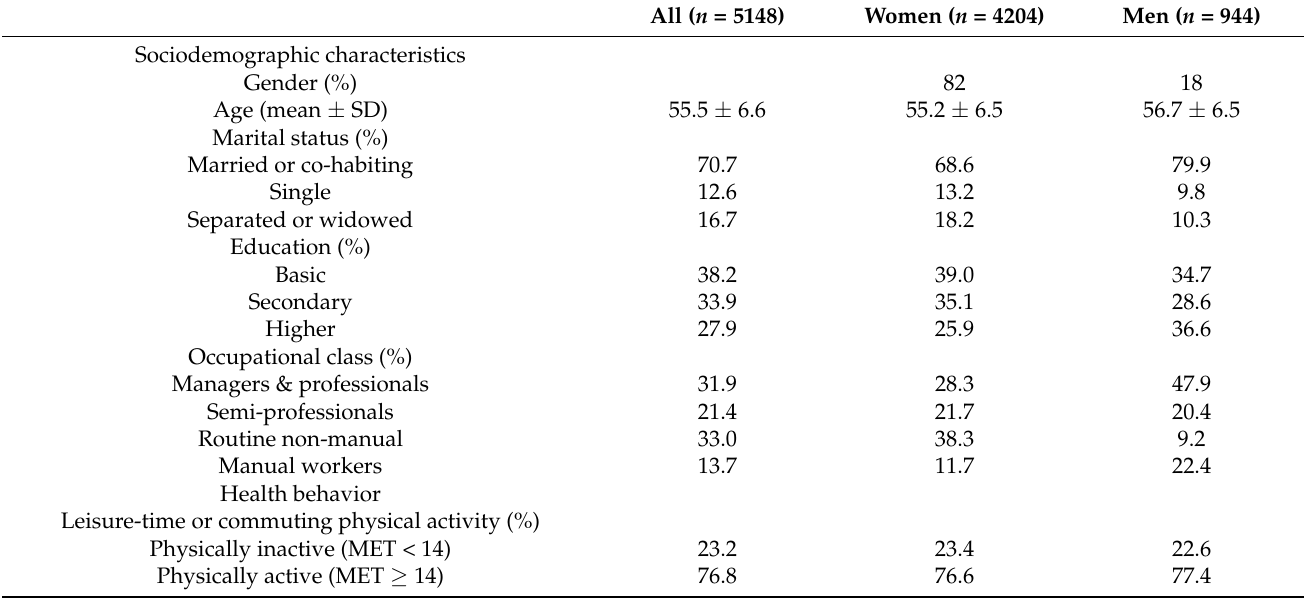
Table 1. Baseline background characteristics of the study